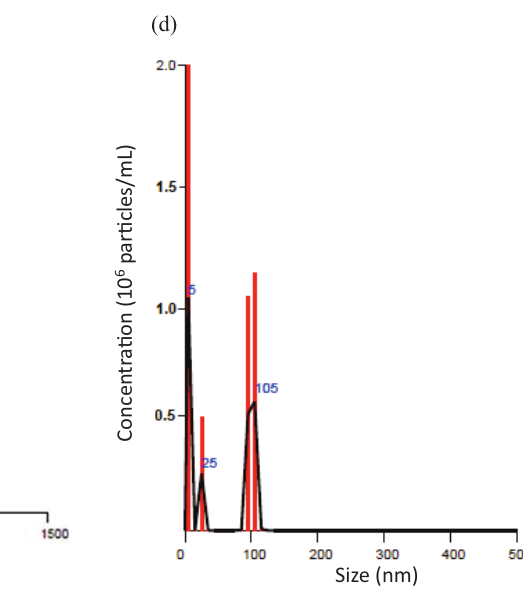
Particle size (nm) and distribution at [SrS] = 0.092 ± 0.01 mM (pH = 9.97 ± 0.02); the average concentration of SrS particles is 5.41 ± 4.38·10 6 per mL. 8#(8%(/$-/*#(,# M ,'-$/*83%&,,*&, G 7 ENFB 7 JGOGB J ,'%$,637,